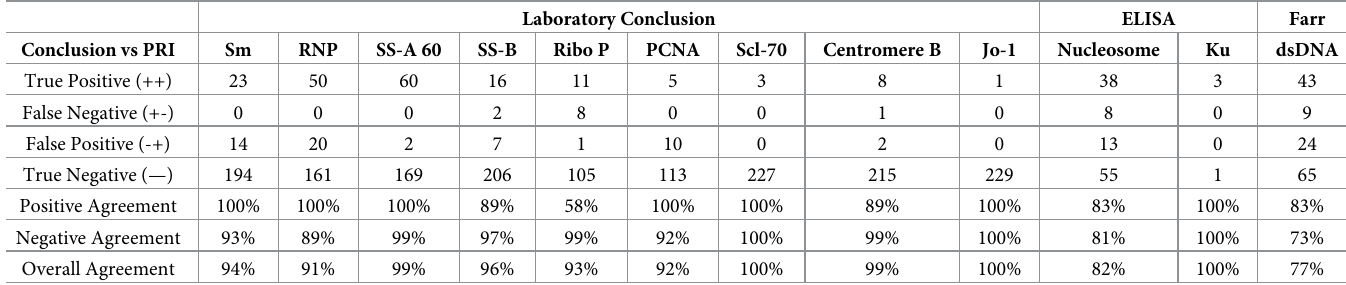
Table 1. Positive and negative percent agreement with laboratory